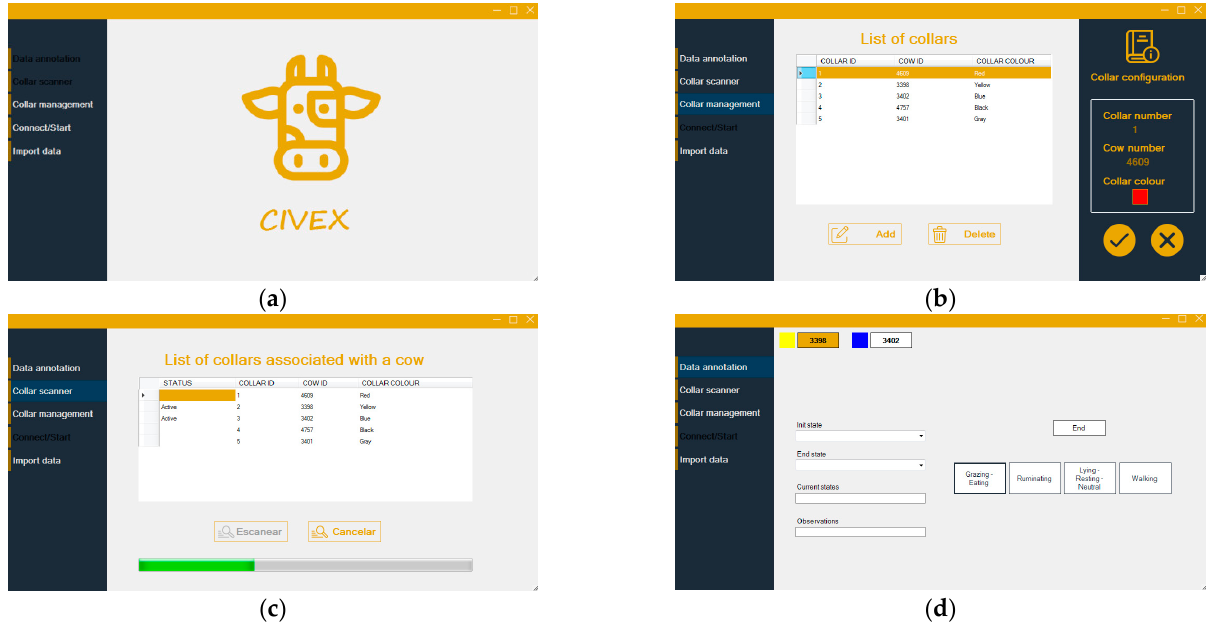
Figure 3. PC Software for collar management and data collection based on visual observation. ( a ) Startup screen; ( b ) collar management; ( c ) collar scanner; ( d ) data annotation.